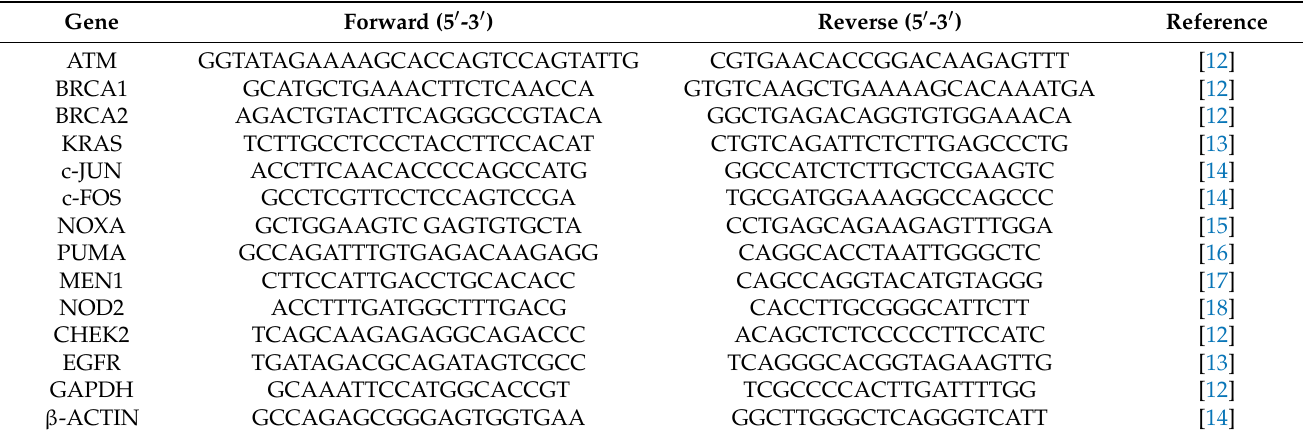
Table 1. Sequences of primers used for real-time